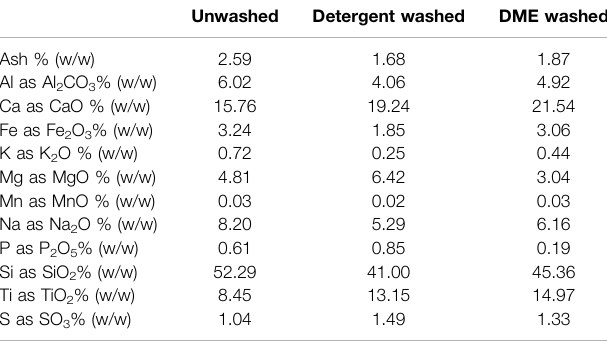
TABLE 3| Ash analysisofunwashed,detergent washed, and DME washed MSW plastic. Ash components are % of total ash